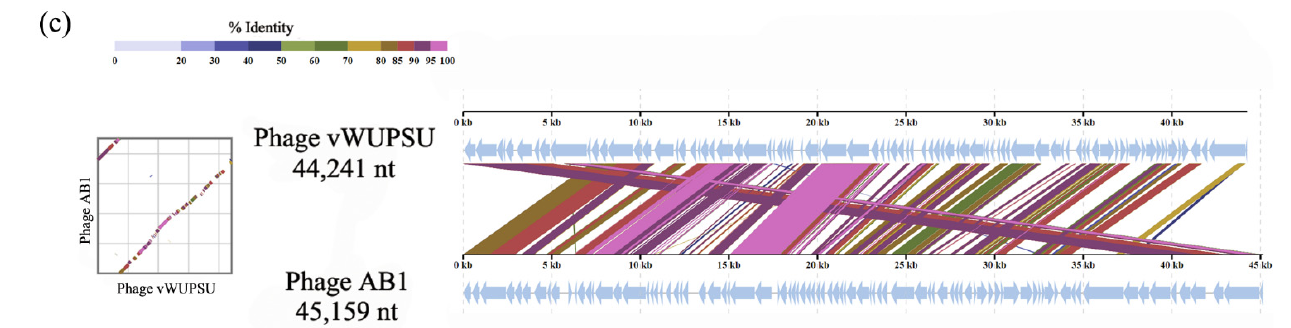
Figure 2. Phage vWUPSU genomic analysis. ( a ) Map of phage vWUPSU genome. The genome map was generated by GC viewer server [28]; ( b ) phylogenetic tree of phage vWUPSU constructed based on the complete genome sequences of selected phages in NCBI BlastN [29]. The phylogenetic tree was produced by VICTOR Classification and Tree Building Online Resource server [30]. The query sequence is marked with an asterisk. ( c ) The whole genome sequence alignment of phage vWUPSU with phage AB1 that had the highest similarity to phage vWUPSU. Homologous regions detected by a TBLASTX search were connected by segments colored based on amino acid identity [29]. The alignment was generated by TBLASTX using ViPTree server [27]. The color bar shows the % identity of